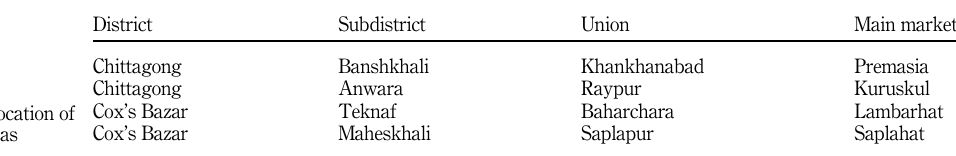
Table 1. Geographic location of the study